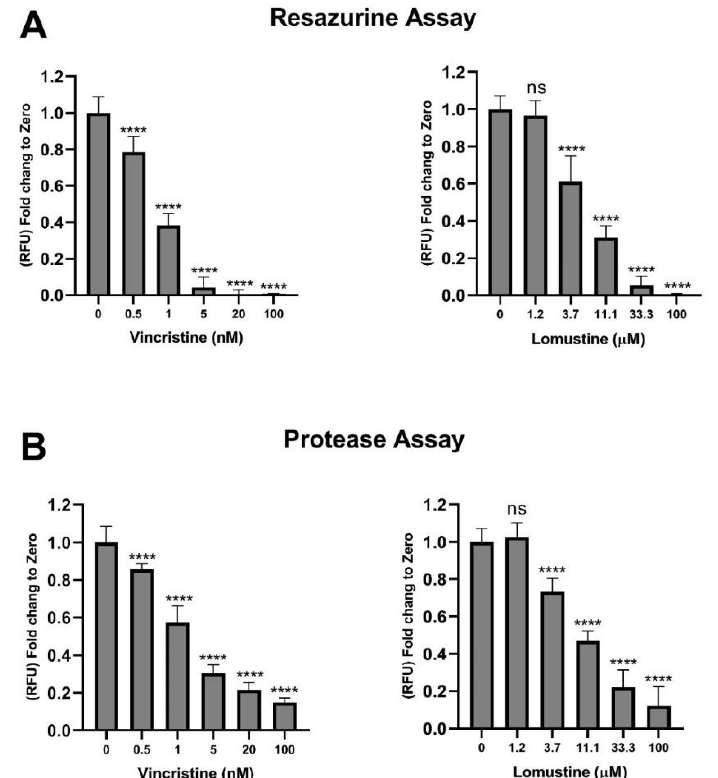
Figure 5. Cytostatic effect of vincristine and lomustine on medulloblastoma (MB) cells. D341 cells (10,000 cells/well in agar) were treated with different concentrations of vincristine (0–100 nM) or lomustine (0–100 µM). After 7 days, plates were analysed using the established multiplex assay and read using plate reader for ( A ) resazurin and ( B ) GF-AFC substrates. Data expressed as mean ± standard deviation from three independent assays with four replicates each. ns = not significant ( p > 0.05), **** p < 0.0001 (one-way ANOVA with Dunnett multiple comparisons test compared with the non-treated 0 control group).